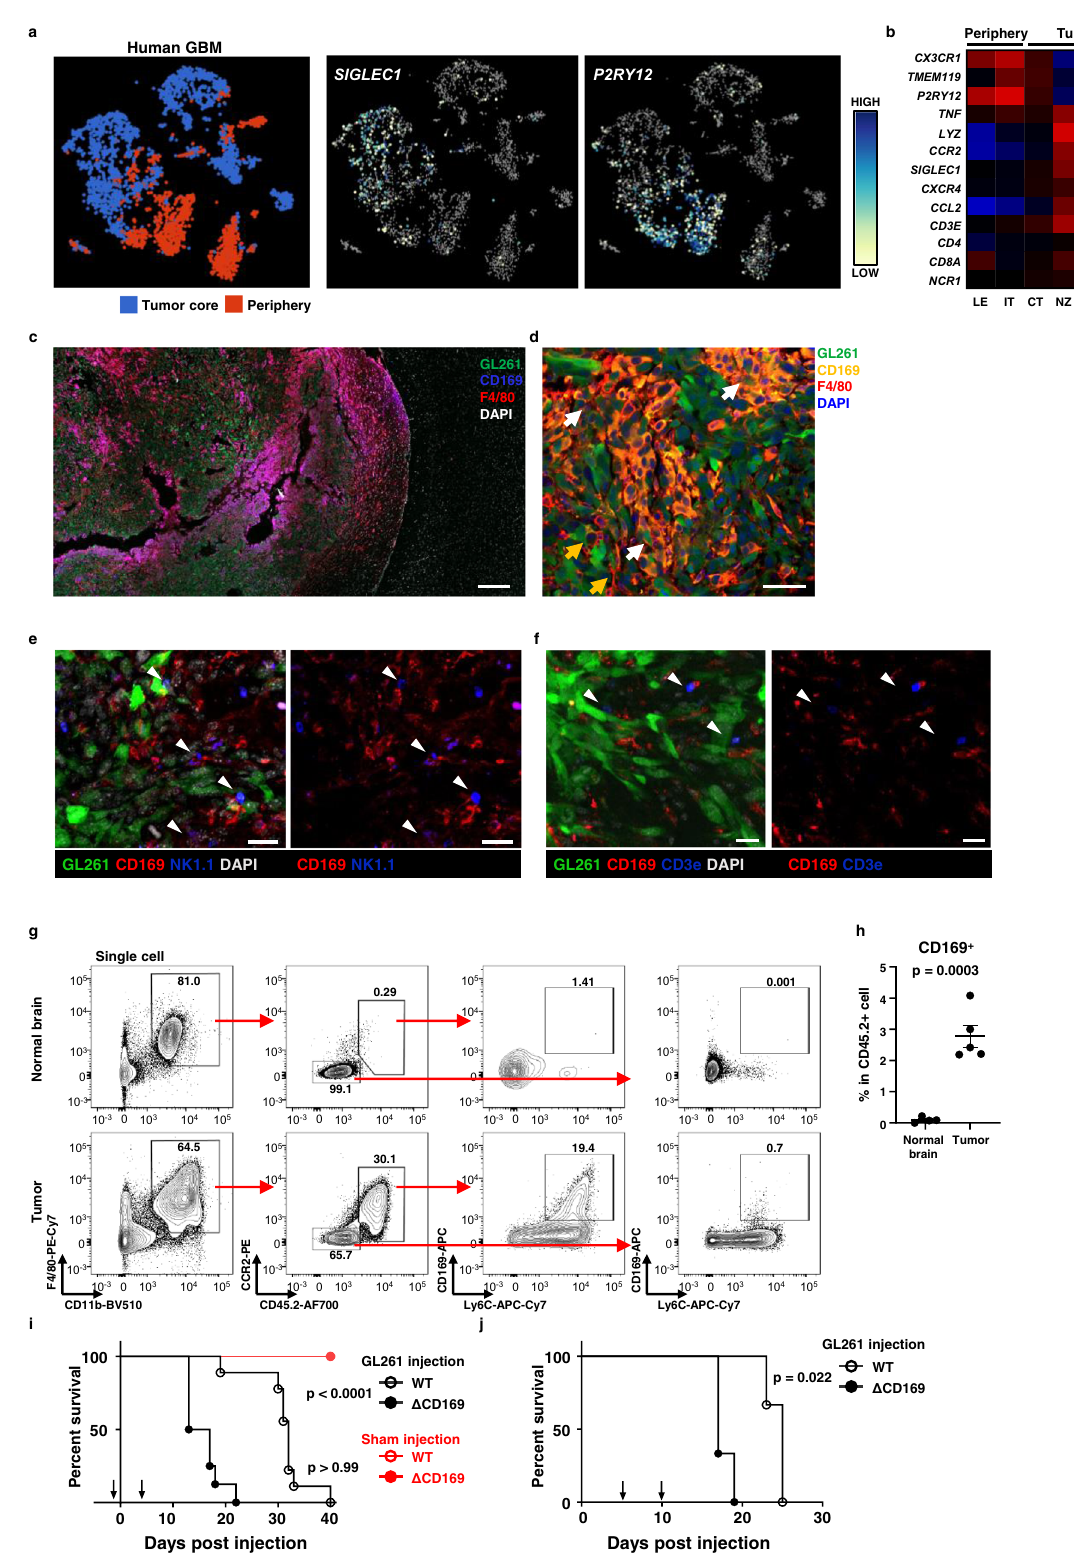
Supplementary Fig. 2i). Depletion of CD169 + macrophages starting at 5 days after GL261 injection also reduced the survival of mice (Fig. 2j and Supplementary Fig. 2j). Reduced survival in mice was con fi rmed under CD169 depletion conditions in the CT2A glioma model (Sup- plementary Fig. 2k). These data suggested that CD169 + macrophages contribute to antitumor immune responses against